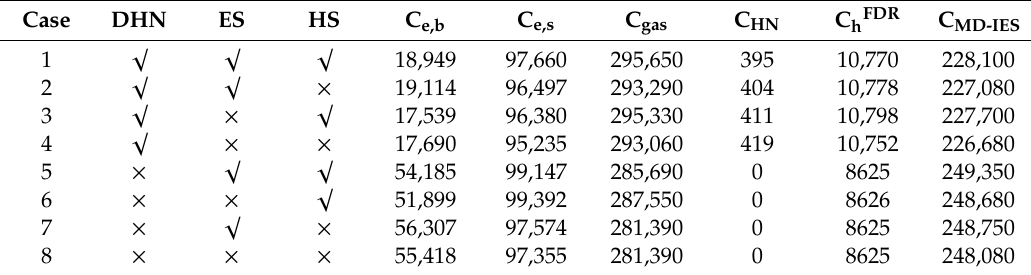
Table 6. Comparison of operating benefits among the district heating network, ES, and HS (Unit: ¥).